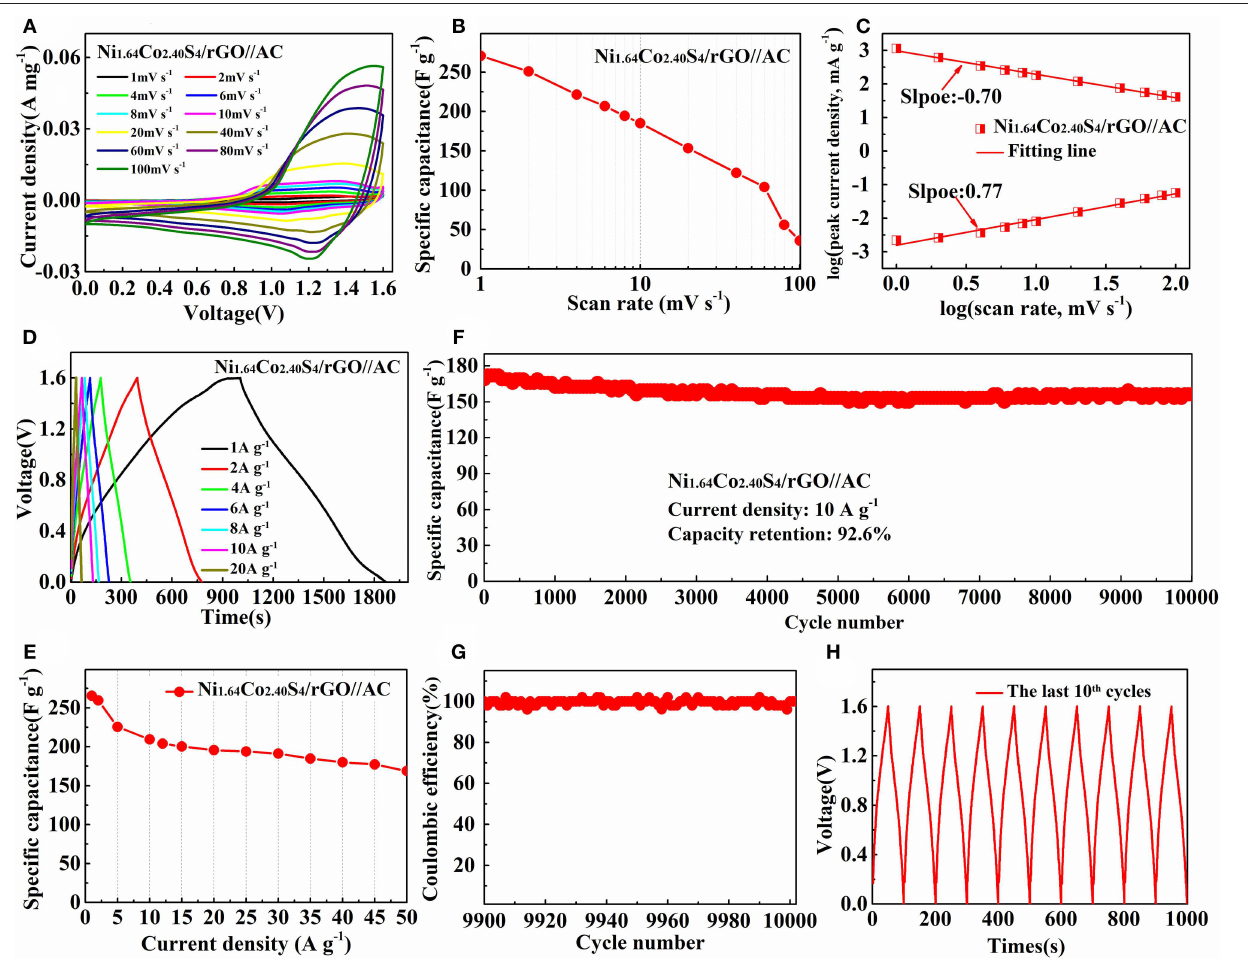
FIGURE 6 | Electrochemical properties of Ni 1.64 Co 2.40 S 4 /rGO//AC asymmetric supercapacitor. CV curves of Ni 1.64 Co 2.40 S 4 /rGO//AC at different scan rates (A) ; specific capacitance of Ni 1.64 Co 2.40 S 4 /rGO//AC calculated from CV curves (B) ; relationship between scan rate and current density of Ni 1.64 Co 2.40 S 4 /rGO//AC (C) ; GCD curves of Ni 1.64 Co 2.40 S 4 /rGO//AC at various current densities (D) ; average specific capacitances in dependence of cycle number at various current densities from 1A g − 1 to 20A g − 1 (E) ; cycle performance of Ni 1.64 Co 2.40 S 4 /rGO//AC at the current density of 10A g − 1 (F) ; columbic efficiency of Ni 1.64 Co 2.40 S 4 /rGO//AC at the last 100 cycles (G) ; GCD curves of Ni 1.64 Co 2.40 S 4 /rGO//AC at the last 10 cycles of 10000 cycles (H) .